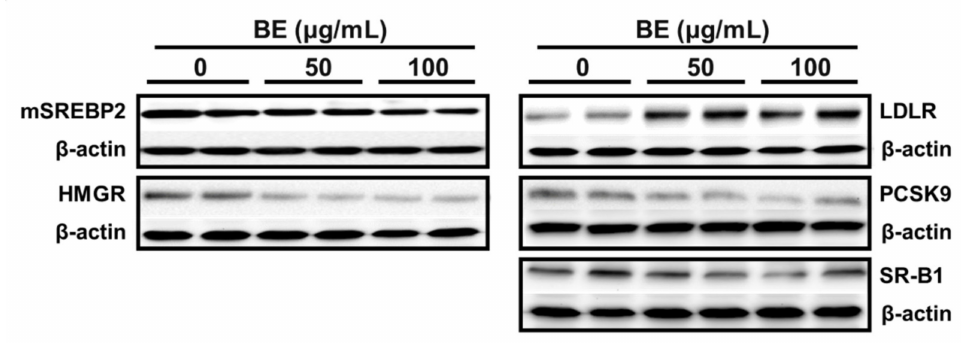
Figure 3. The effects of BE on the protein levels for cholesterol de novo synthesis and uptake in HepG2 cells. Cells were treated with either 50 or 100 µ g/mL of BE for 24 h. The representative images of Western blot are shown. β -actin served as a loading